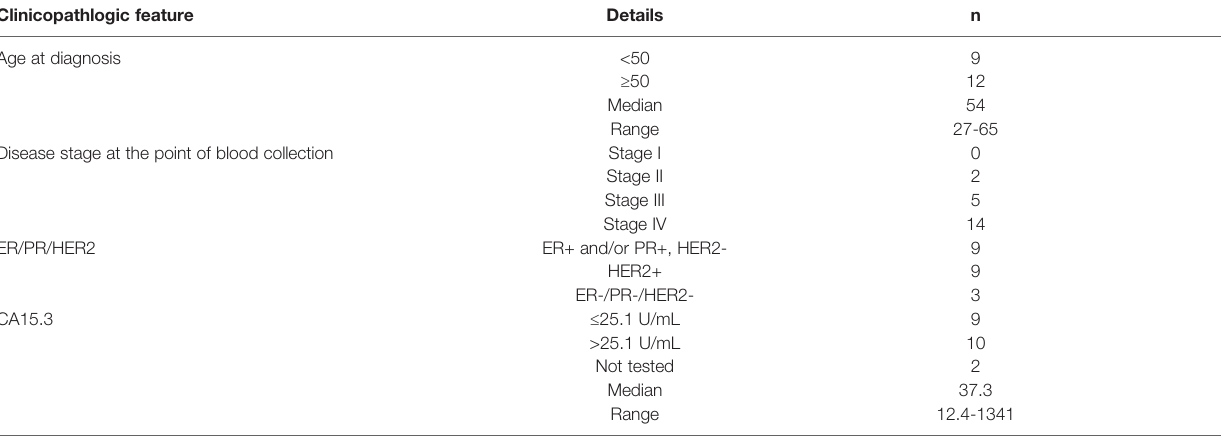
TABLE 2 | The clinicopathological features of breast cancer patients recruited in this study. Clinicopathlogic